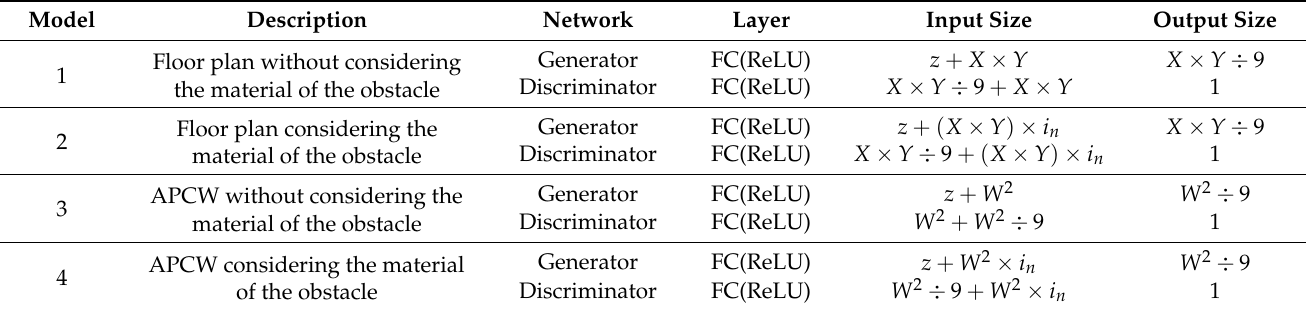
Table 5. Network Definition and Architecture.